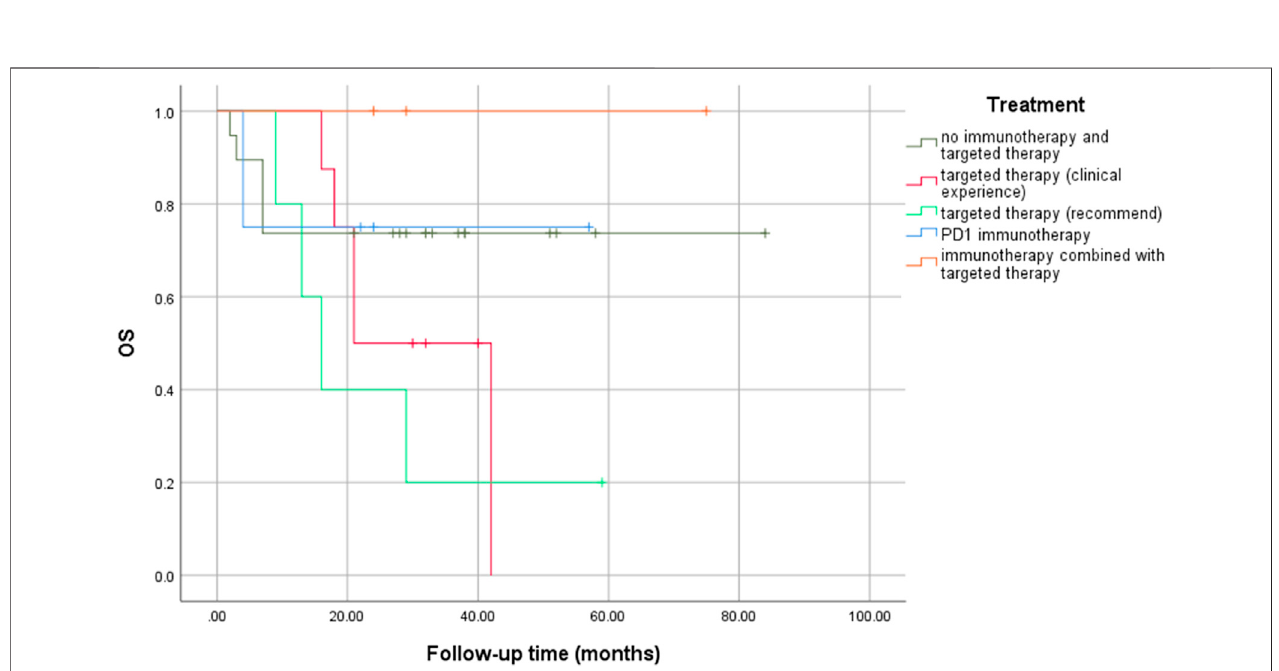
FIGURE 4 | Comparisons of OS rates in different treatment